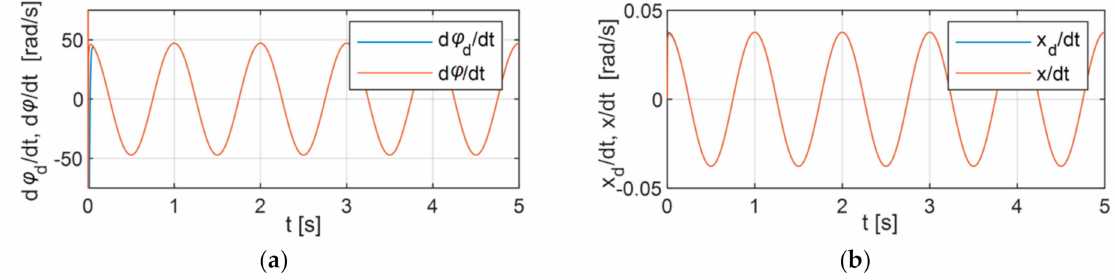
Figure 13. Trajectory: ( a ) adjusted d ϕ d / dt and realized d ϕ / dt speeds of the active part; ( b ) adjusted dx d / dt and realized dx / dt speeds of the passive